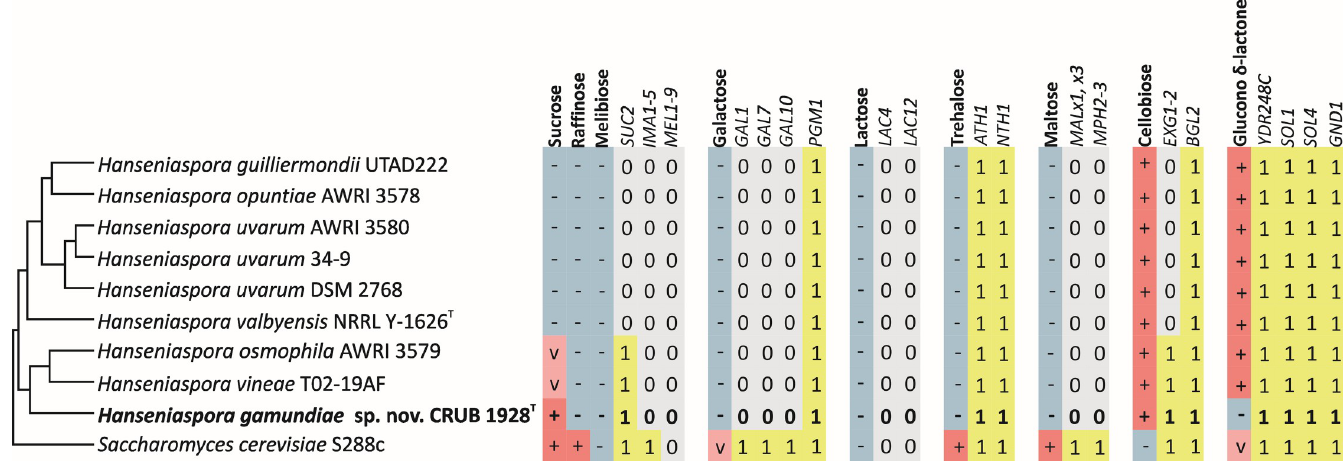
PLOS ONE | https://doi.org/10.1371/journal.pone.0210792 January 30,